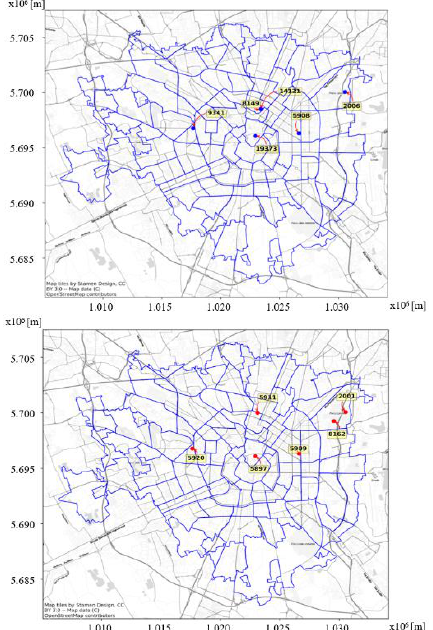
Figure 11. Meteorological sensors network from ARPA Lombardia (within Milan administrative boundaries). Rainfall